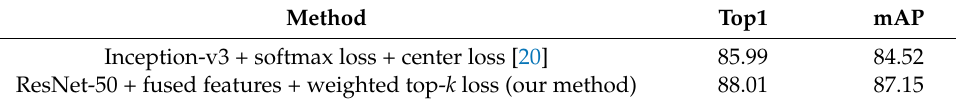
Table 9. Recognition result of our method and the method proposed by [20]